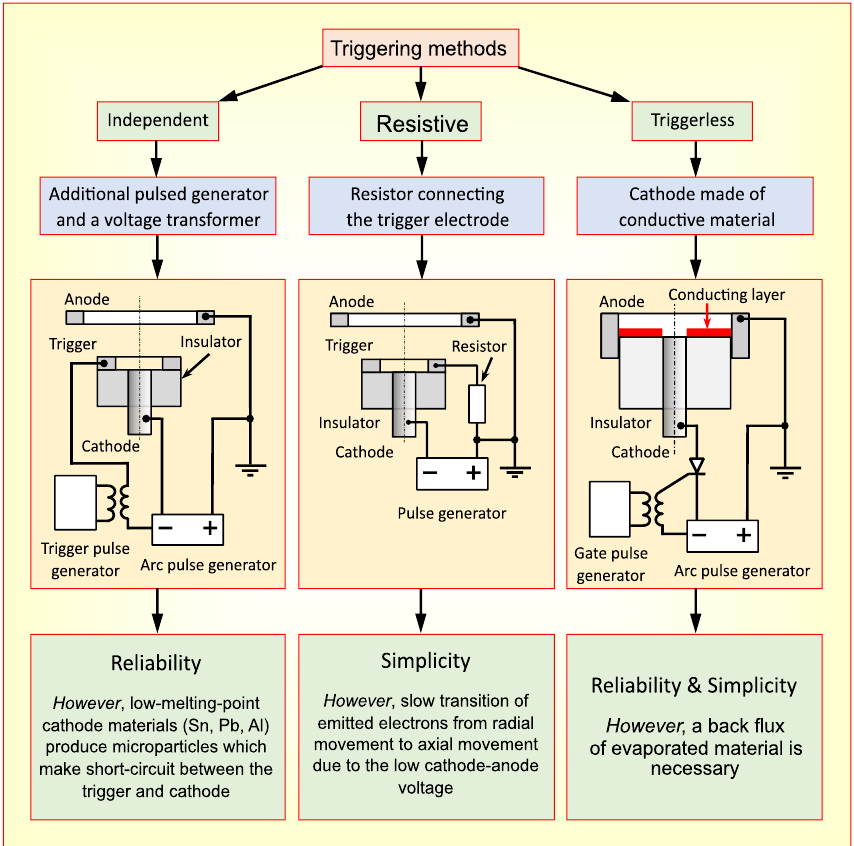
Figure 5. Triggering methods for various types of arc plasma sources, for potential application in space propulsion systems. This scheme illustrates only one aspect of plasma generation in arc plasma sources, while the operation of thrusters producing an accelerated plasma jet involves a wide variety of the intertangled processes, including processes of ion acceleration and other key factors that underpin thruster physics. Reproduced with permission from Ref. [26]. Copyright 2019,